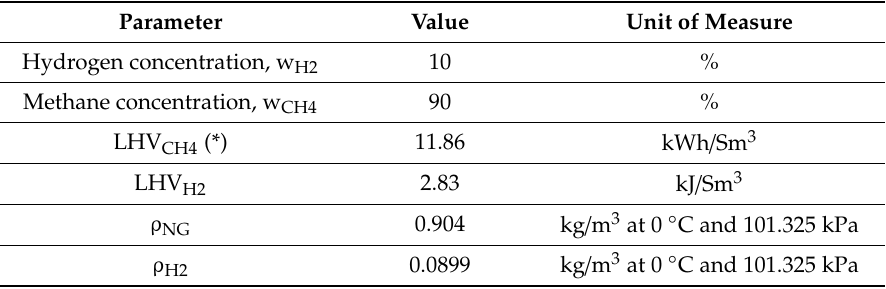
Table 3. Values assumed for the evaluation of hydrogen blending